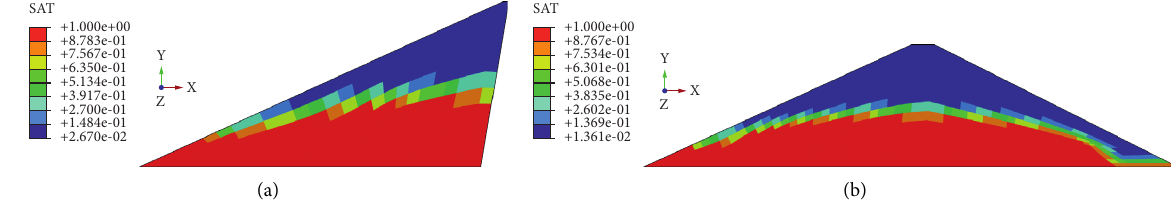
Figure 9: The saturation distribution at 1,200hours: (a) the CCD and (b) the homogeneous